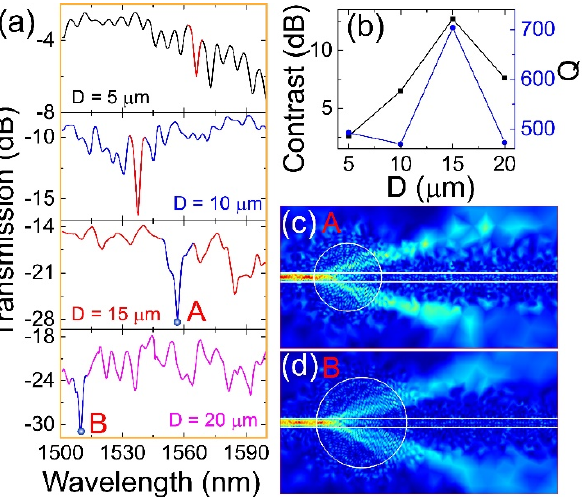
Figure 2. ( a ) The transmission spectra of silica taper-assisted only one microsphere under different D . ( b ) The corresponding comparisons of the contrast and quality factor (Q) under different D . ( c , d ) Electric field distributions at point A and point B in Figure 2a.